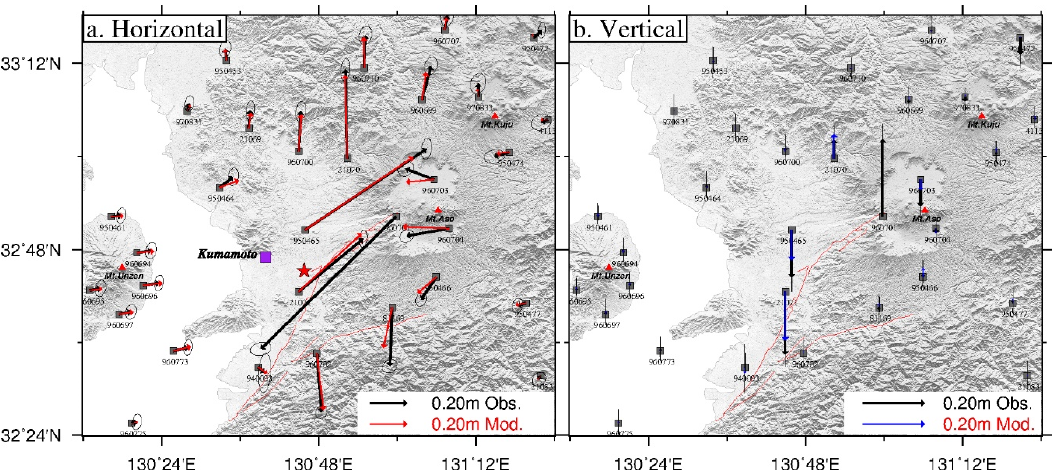
Figure 3. Observed co-seismic GPS displacements compared with modeled displacements from the preferred model. ( a ) Horizontal displacements with exaggerated 95% confidence ellipses and ( b ) vertical displacements. Red star and red triangle denote the mainshock epicenter and Aso volcano, respectively.